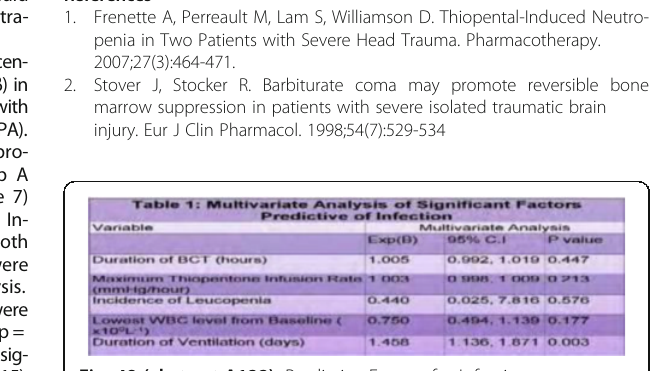
Fig. 48 (abstract A122). Predictive Factors for Infections